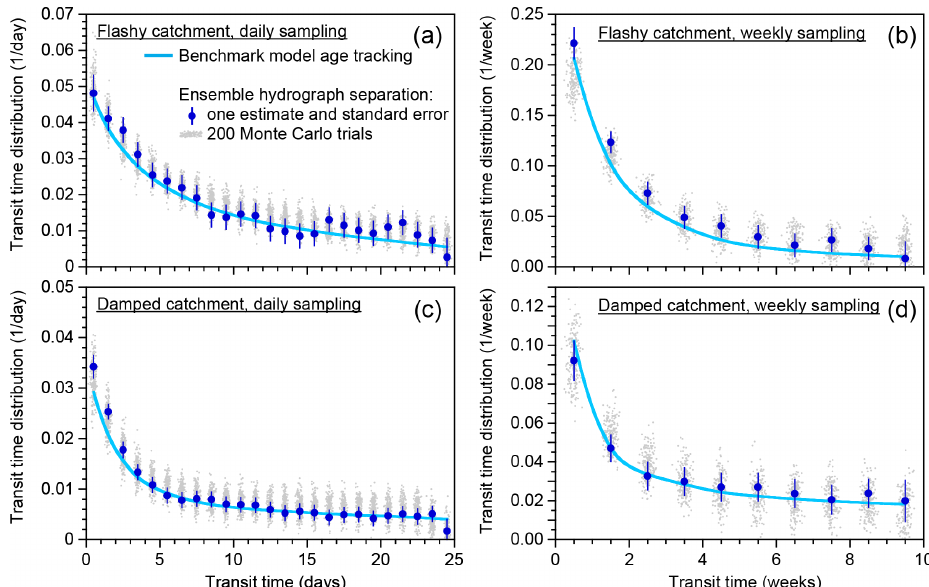
Figure 11. Transit time distributions of discharge estimated by ensemble hydrograph separation based on both daily and weekly tracer sampling, versus true transit time distributions determined by benchmark model age tracking (light blue curves). Panels (a–d) show TTDs for the modeled flashy and damped catchments, both driven by Smith River (Mediterranean climate) precipitation. Dark blue symbols show transit time distributions estimated from one time series. Data clouds show ensemble hydrograph separation results (slightly jittered on the horizontal axis) from 200 different realizations of random precipitation tracer values, random missing data, and random measurement errors. Ensemble hydrograph separation correctly reveals the shapes of the transit time distributions and also quantifies their values, within the calculated uncertainties, at most lags. It can clearly distinguish the transit time distributions of the two catchments under either daily or weekly tracer